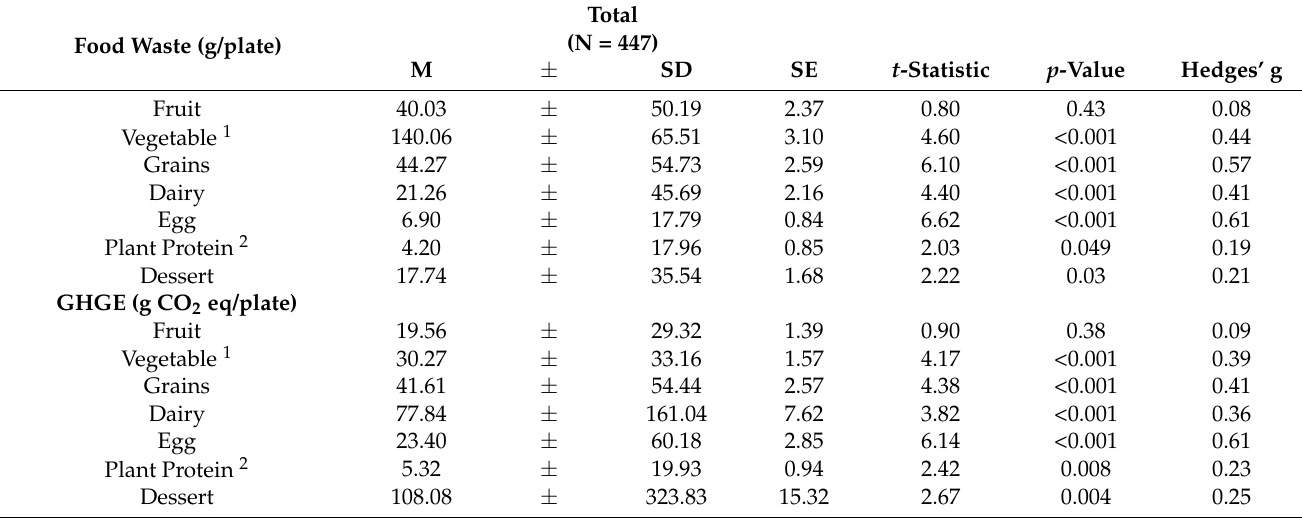
Table 1. Exploratory comparison analyses for food waste (g/plate) and GHGE (g CO 2 eq/plate)